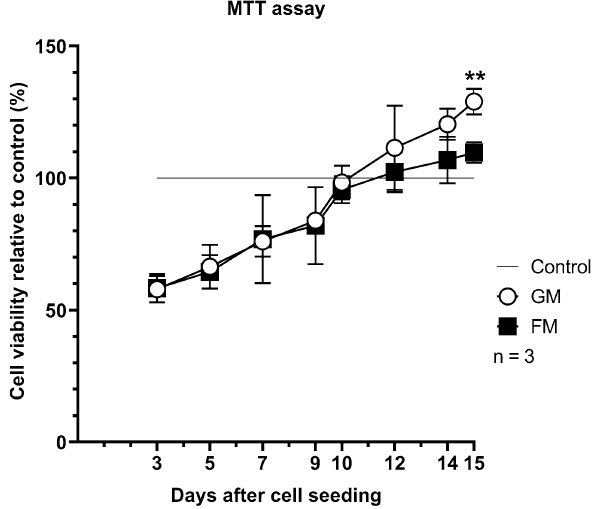
Figure 1. Cell viability of hDPSCs in gelatin-based and fibrin-based matrices. DPSCs were cultured in gelatin- based and fibrin-based three-dimensional (3D) scaffolds and in two-dimensional (2D) conditions without scaffolds as controls. For each time point, optical density measurements of cells in 2D conditions served as references and were set to 100%. On the 15th day of cell seeding, gelatin-based scaffolds exhibited significantly higher cell viability than fibrin-based scaffolds ( P < 0.01, P = 0.0058). Three cell lines from three donors were used. ** P < 0.01.